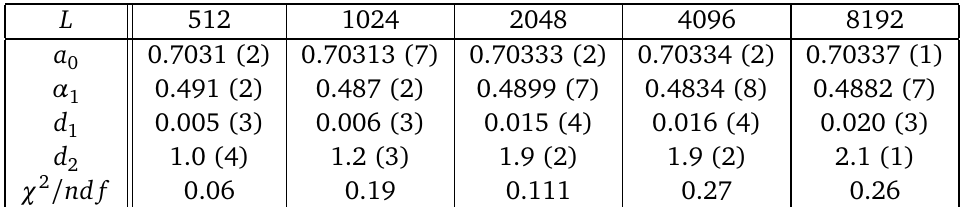
Figure A.4: Numerical results for r cases Q = 1,2,3, and the best power law fits. Table A.5: Parameters of the fit (144) in the case of the Ising model ( Q = 2), as functions of the lattice size L